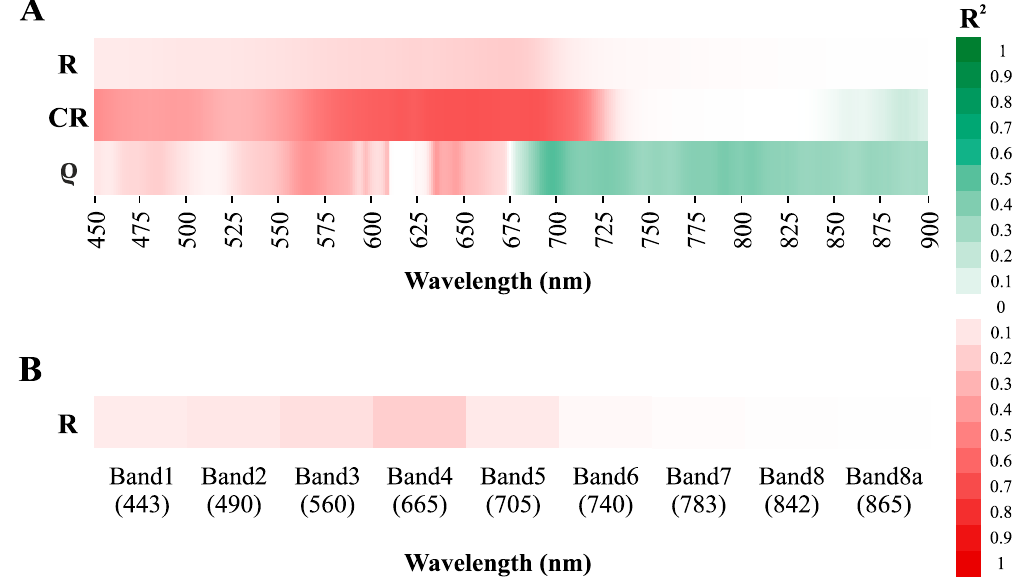
Figure 6. Comparing the coefficient of determination (R 2 ) between reflectance (R), continuum removal (CR), and first derivate of reflectance ( ρ ) and chlorophyll a concentration for all the studied communities calculated with the hyperspectral ( A ) and Sentinel-2 resampled ( B ) data. I: incipient, C: cyanobacteria-dominated, L: lichen-dominated, and M: moss-dominated. Green scale values of the coefficient of determination indicate a positive relationship between response variable (Chl a ) and predictor factor (spectral information), whereas red scale values indicate a negative relationship.